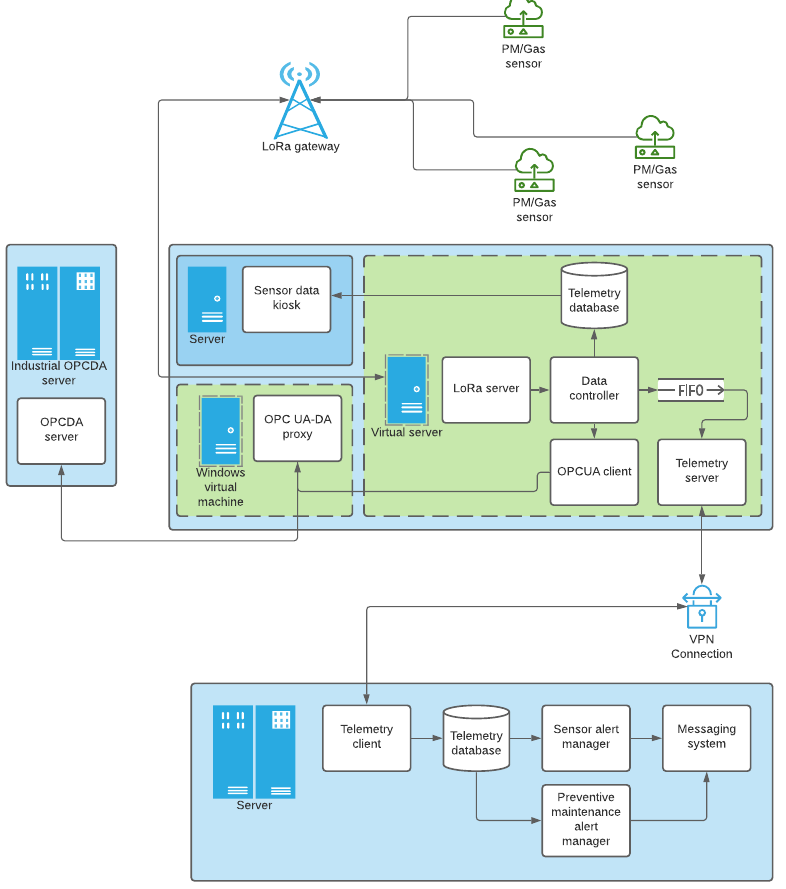
Figure 1. System